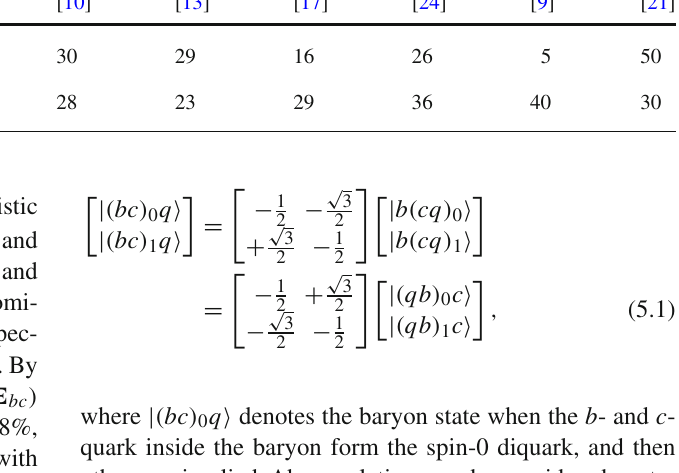
Table 3 Comparisons of the mass splittings ( M (cid:2) (cid:2) with 1 + ( bc ) -diquark cores, and the primed ones correspond to those with 0 + ( bc ) -diquark cores Baryon This